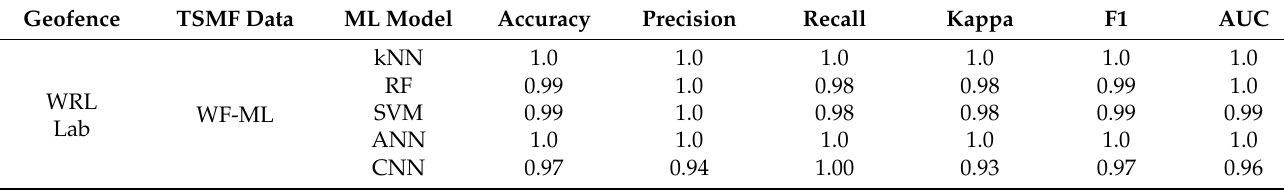
Table 1. WRL Lab Indoor WF-ML results.